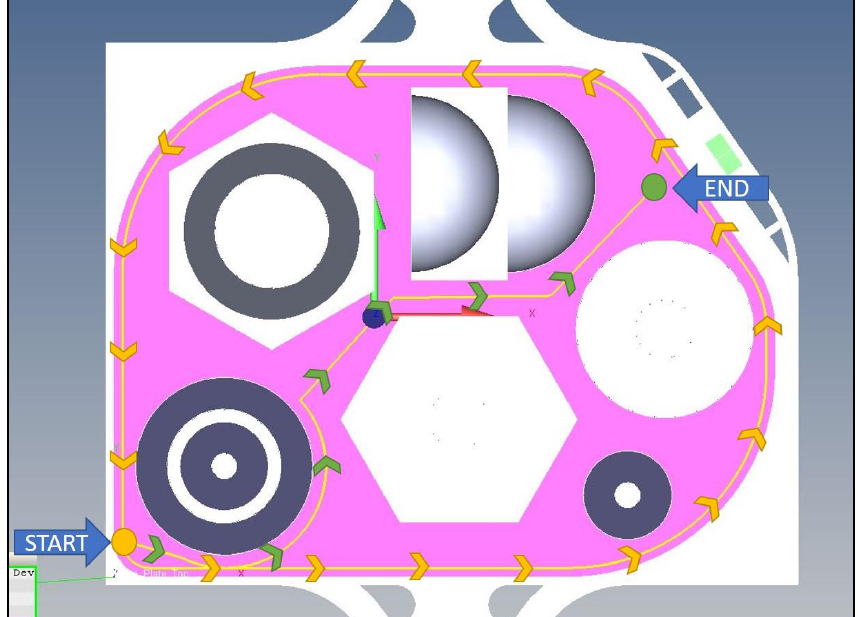
Figure 16. Inspection strategy for the base plate. A single path follows the edge of the base plate before trailing off towards the interior.